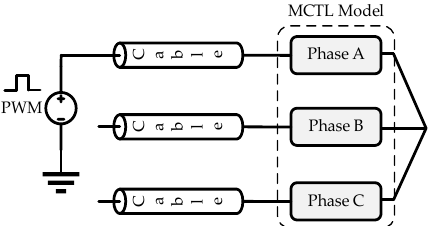
Figure 21. Coil-to-core voltages of different coils when a single-phase model is implemented and is excited by a 560 V PWM voltage with 𝑡 𝑟 = 20 ns and the neutral point is floating. Figure 22. Three-phase model with floating neutral point.